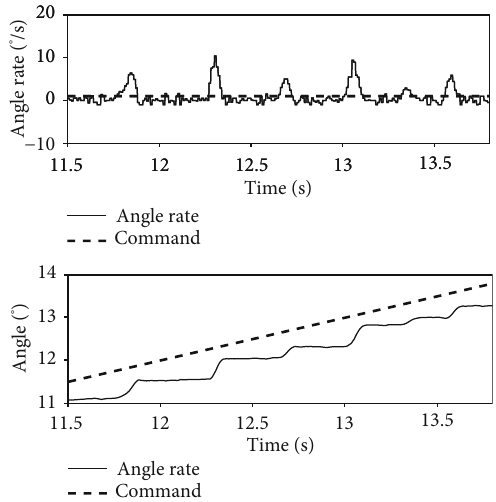
Figure 9: The fl ow regulator could not easily achieve uniform motion due to the stick